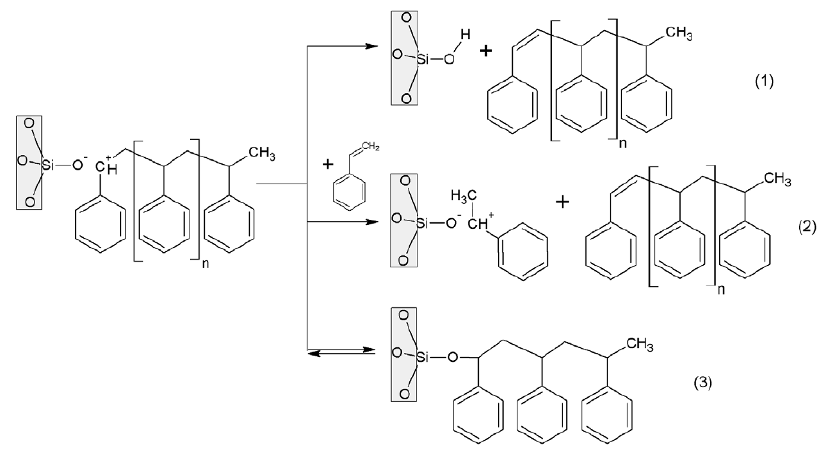
Scheme 5. Schemes of chain termination in case of heterogeneous catalytic cooligomerization.